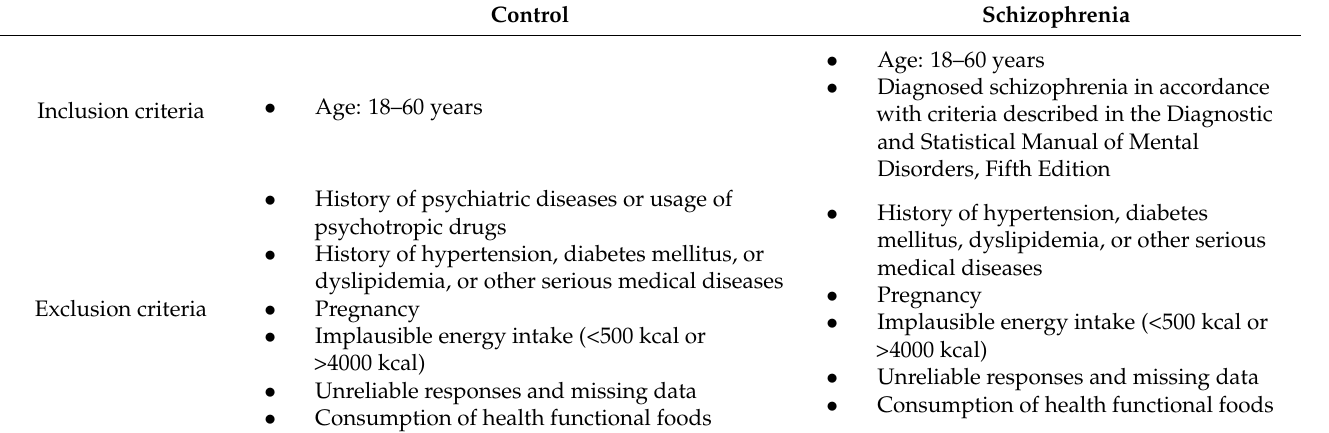
Figure 1. Flow diagram for study participants. SQ-FFQ, semi-quantitative food frequency questionnaire. Table 1. Inclusion criteria and exclusion criteria for study participants .